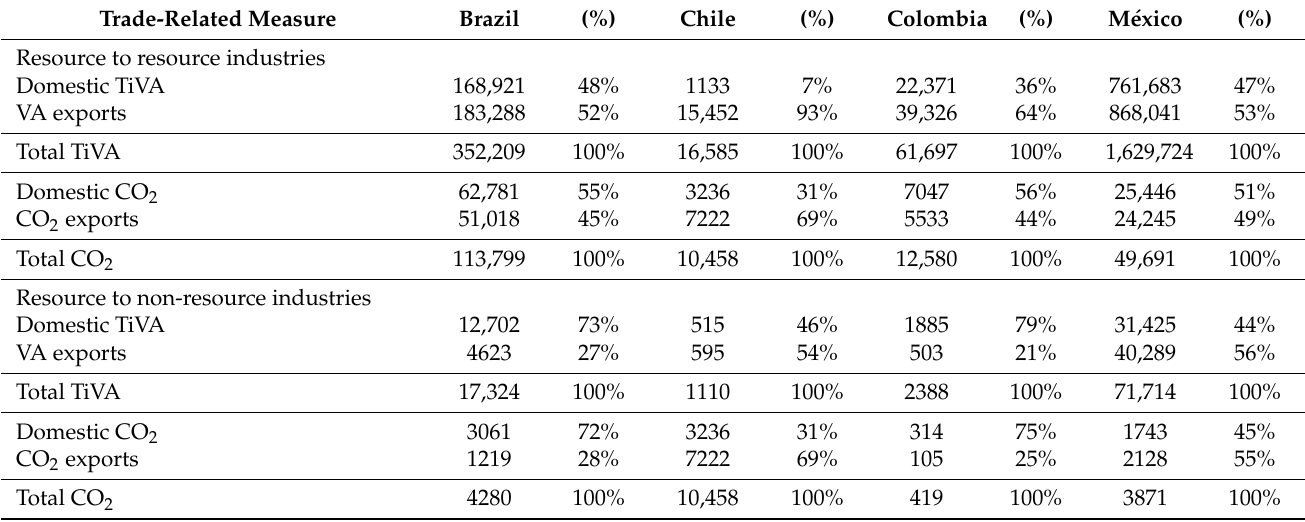
Table 6. Interplay in VA 1 and CO 2 emissions trade (from industries’